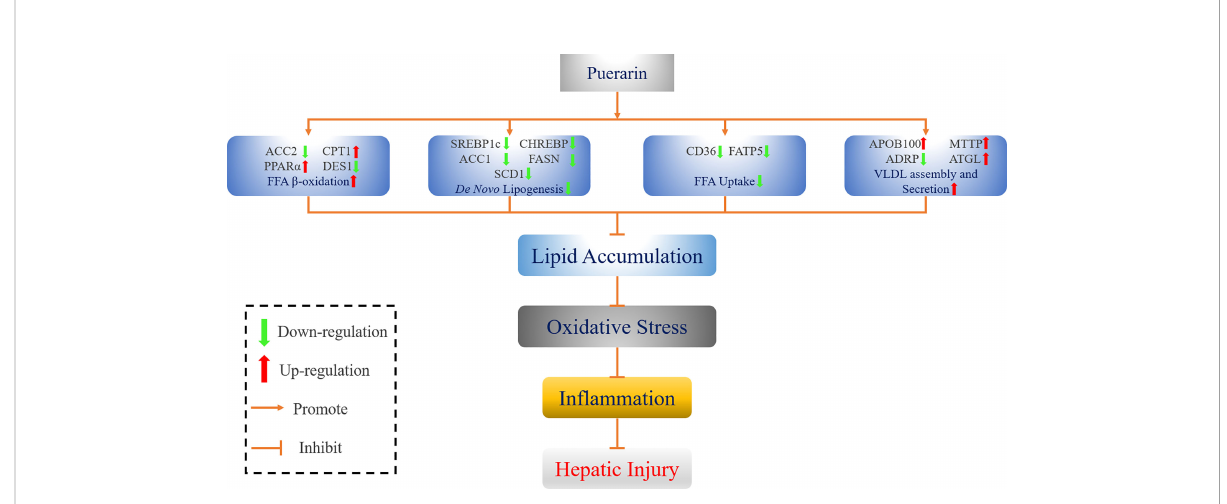
FIGURE 9 Schematic diagram of the mechanism by which puerarin ameliorates